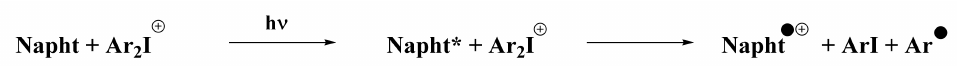
Figure 11. Cyclic voltammetry of Napht-B1 dye in acetonitrile, in the presence of tetrabutylammonium hexafluorophosphate 0.1 M as a supporting electrolyte, under nitrogen.